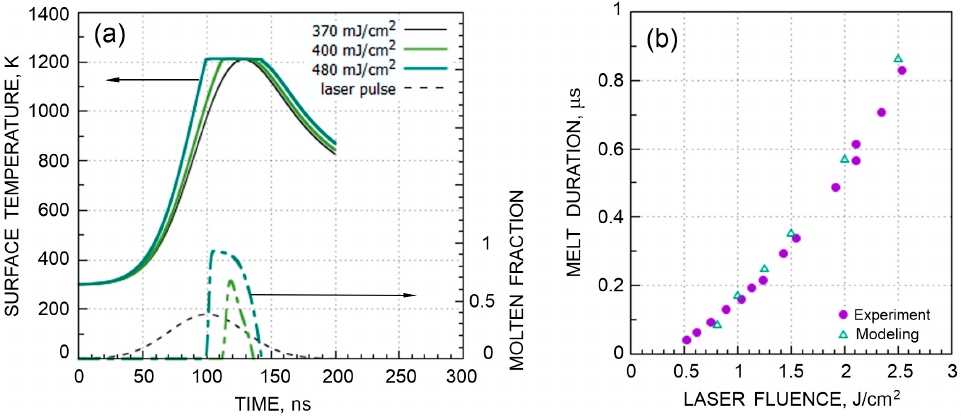
Figure 1. ( a ) Surface temperature (solid lines) and molten fraction (dot-dashed lines) of germanium obtained in the modelling for different laser fluences (694-nm, 70-ns pulse). The laser temporal profile is shown by the dashed line. ( b ) Comparison of the duration of increased reflectivity (data from experiment [10]) and the melt duration obtained in our simulations.